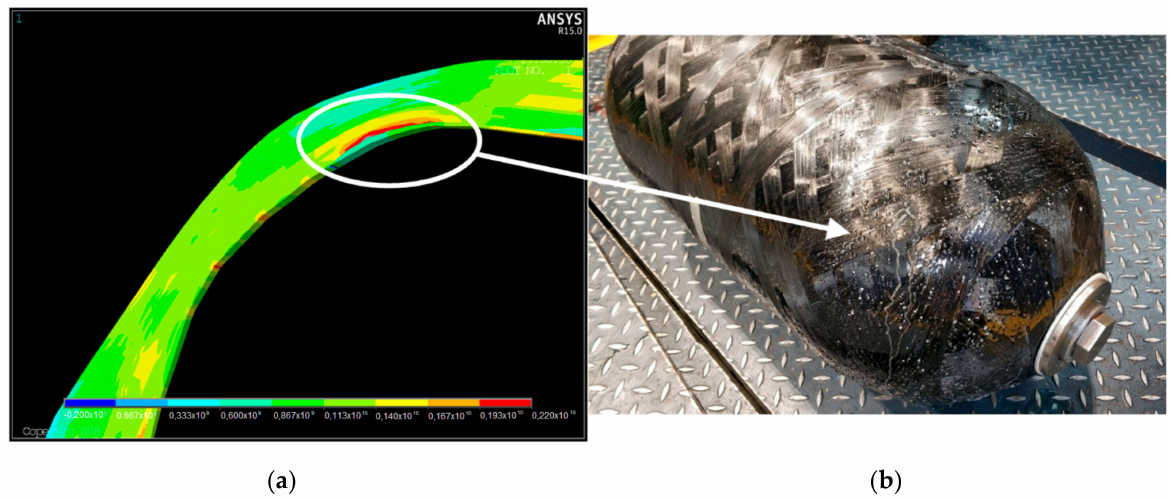
Figure 6. A 5-degree segment of the vessel model (ANSYS V15) presented normal stress (fiber orientation direction) in the composite material; ( a ) hotspot located in the dome area was the reason for liner damage and medium leakage [30]. ( b ) View of the leaking hydrogen vessel during the hydraulic test due to the cracks in the PE liner in the outlet dome area (water drops on the dome surface leaking through the pores in the composite